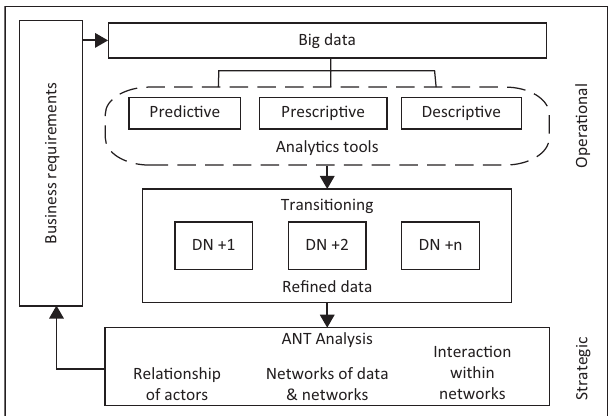
FIGURE 2: Multilevel analysis of big